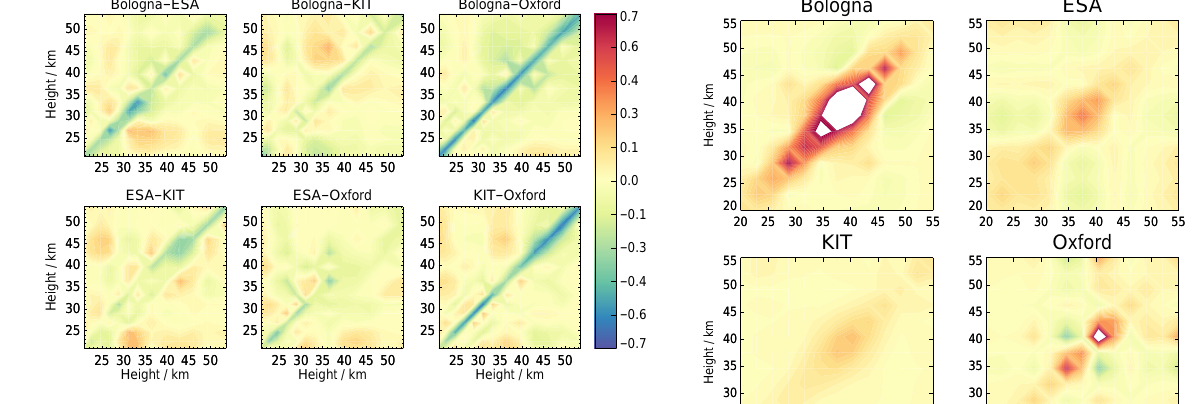
Figure 1. Correlation of errors of four processors calculated by Eq. (11). Obtained matrices are not symmetric, which is to be ex- pected. The errors are non-negligibly correlated for all six pairs, which means that the coefficients can not be assumed zero and must be taken into the merging formula.